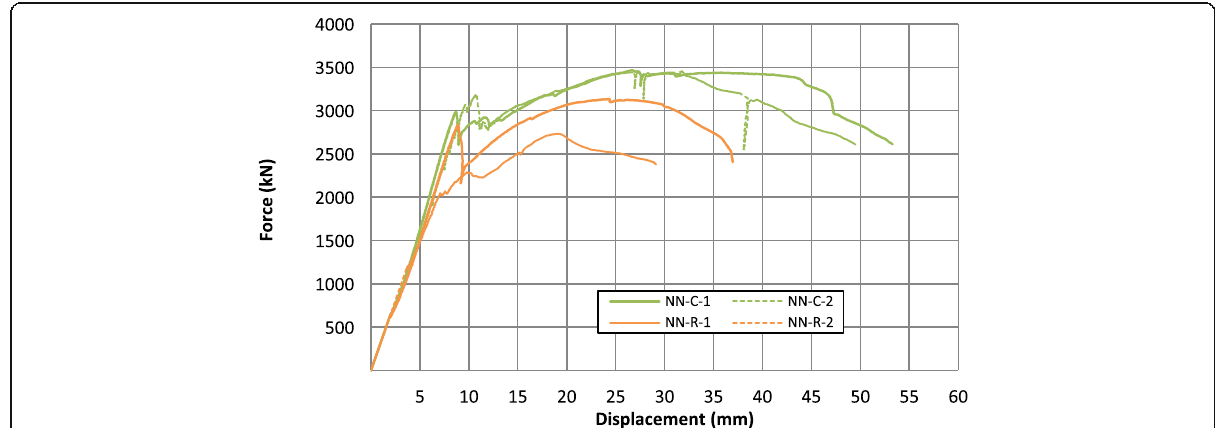
Fig. 13 Compression force versus axial displacement for NN series specimens with stainless steel vertical bars and stainless steel spiral